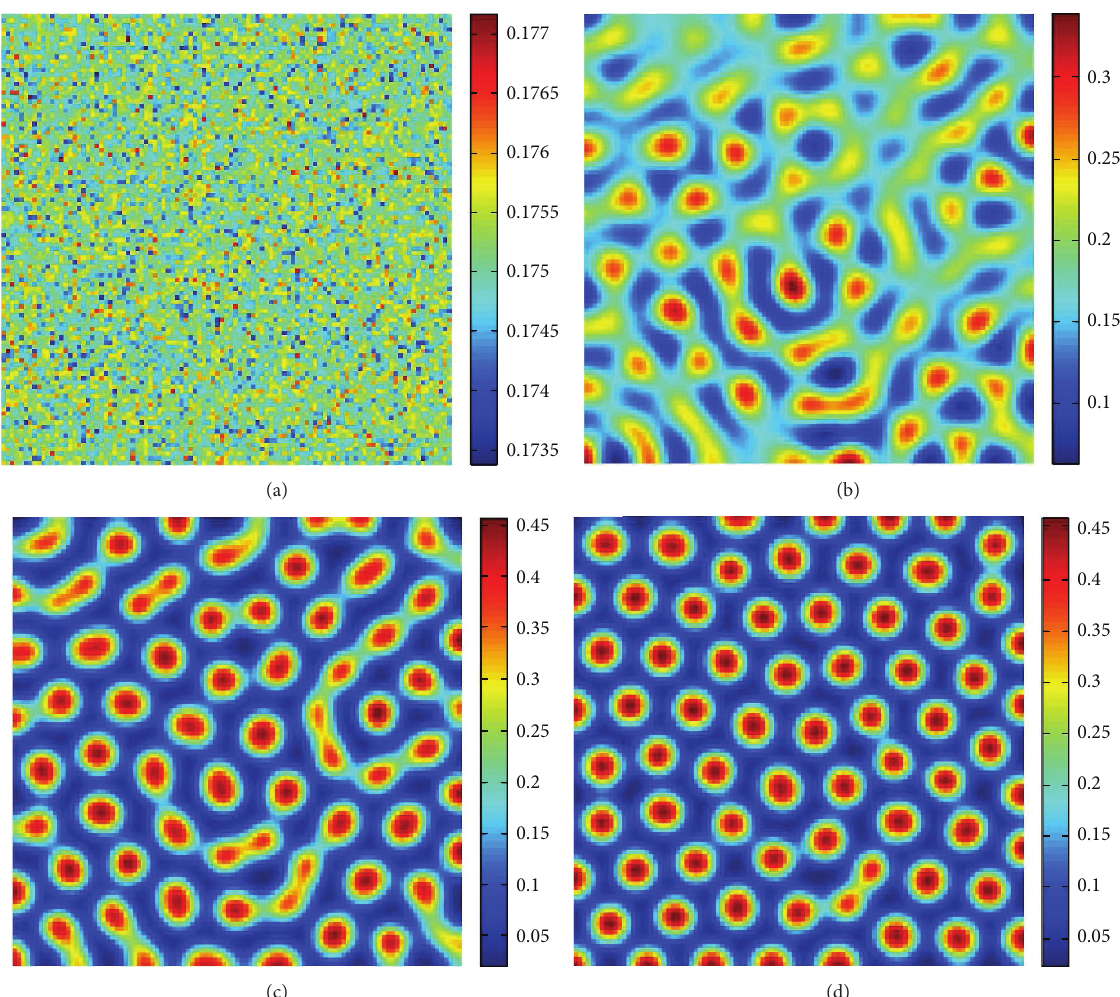
Figure 3: Typical Turing patterns of 𝑢 in model (7) with parameters 𝛼 = 1 , 𝛽 = 0.3 , 𝛾 = 0.3 , 𝑏 = 0.5 , 𝑐 = 0.6 , 𝑚 = 0.6 , 𝑞 = 0.35 , 𝑠 = 3.0 , = 0.015 , and 𝑑 = 1 . Times: (a) 0; (b) 50; (c) 250; (d) 𝑑 1 2